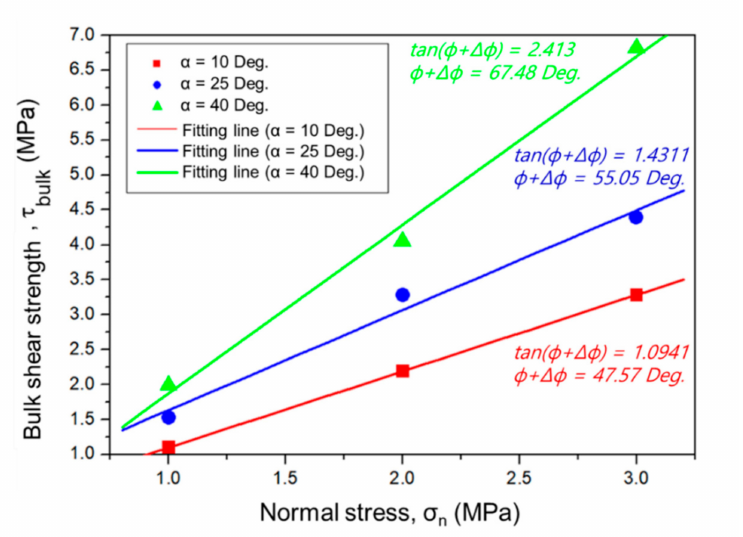
Figure 16. Linear fitting lines of various values of σ n (i.e., σ n = 1.0, 2.0 and 3.0 MPa) under each α ( α = 10, 25 and 40 degrees) based on the Mohr–Coulomb (MC) shear failure